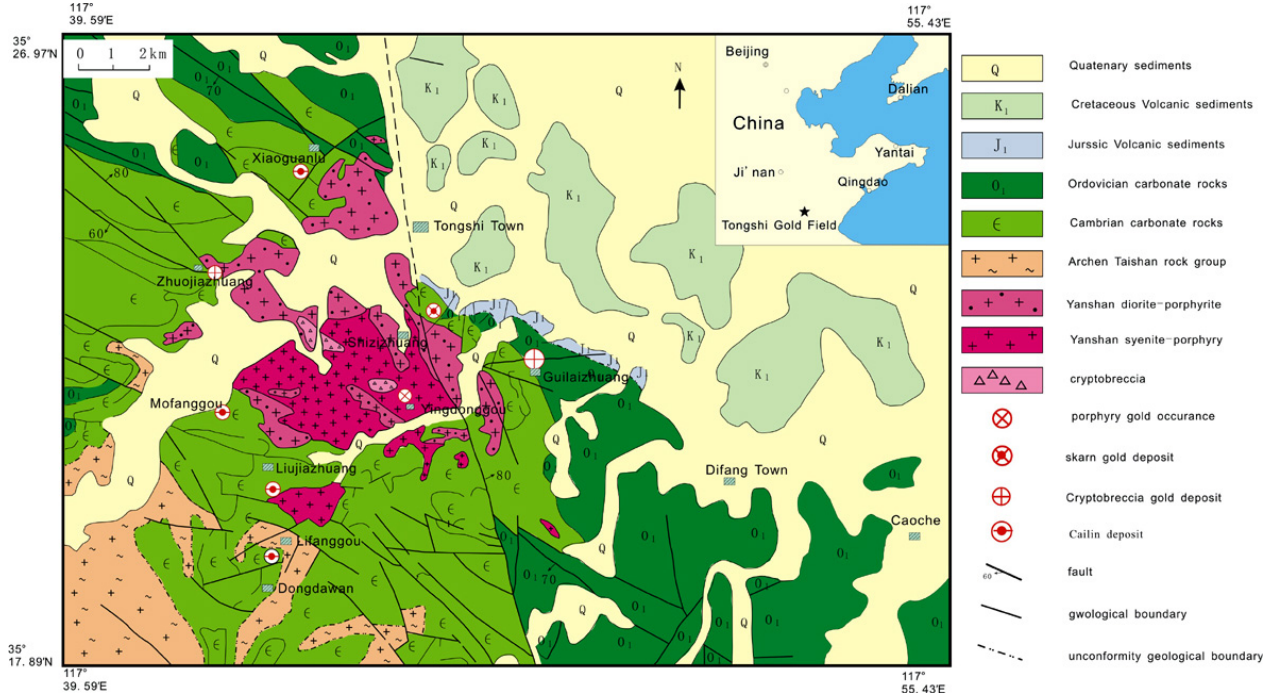
Fig. 1. Geology and mineralization of the Tongshi gold field, Western Shangdong Uplift Block, Eastern China (revised after Chen et al.,